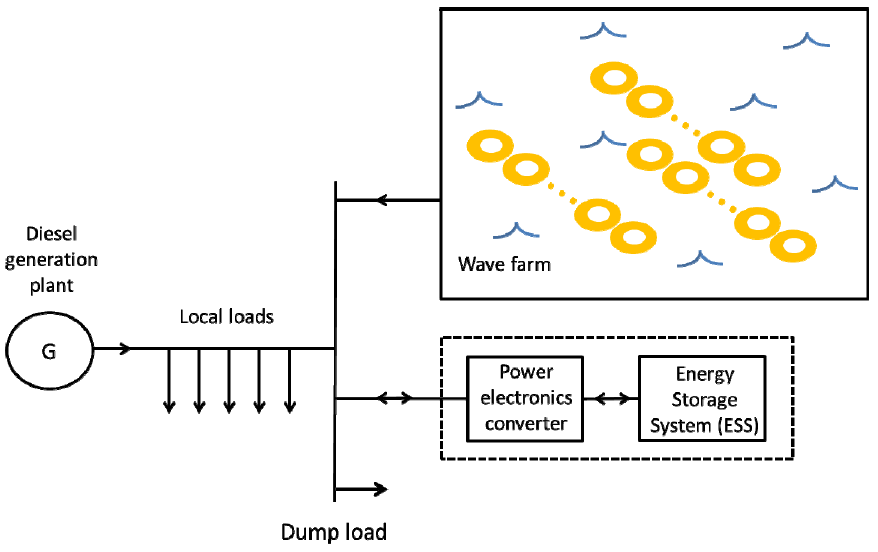
Figure 2. Isolated wave/diesel power system, including energy storage device and dump